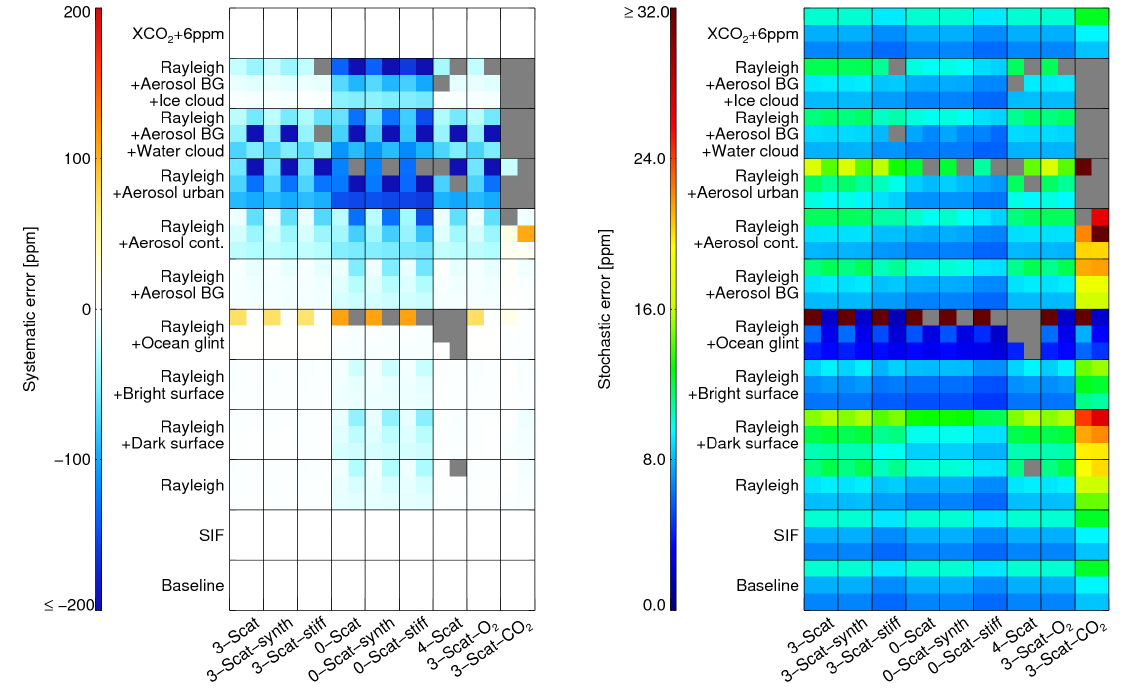
Figure 10. As Figure7 but for XH 2